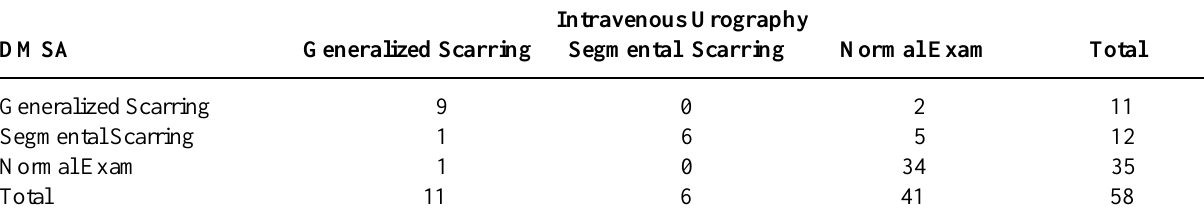
Table 3 – Classification of renal scarring: comparison between scintigraphy with DMSA and intravenous